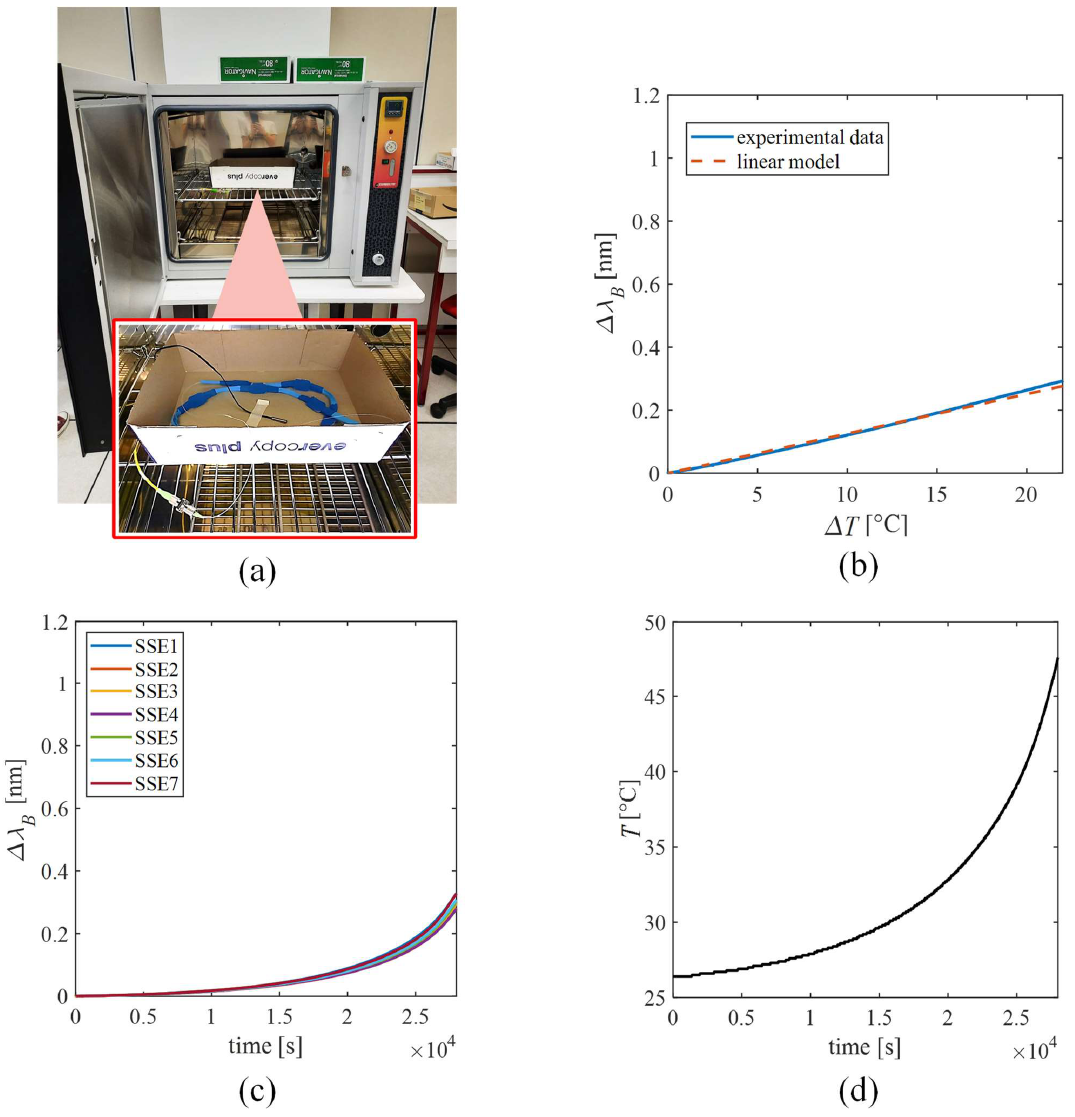
Figure 4. Response to temperature of the SSEs. ( a ) The laboratory oven and a zoom of the wearable system placed inside the oven. ( b ) The calibration curve of Δλ B vs. ΔT of SSE2 is given as an example. The experimental Δλ B signal is shown as the blue line, while the linear model is shown as the dotted purple line. ( c ) The 𝛥 λ B vs. time of all the SSEs. ( d ) The temperature vs. time. Table 2. Values of the. S T obtained for the seven SSEs.